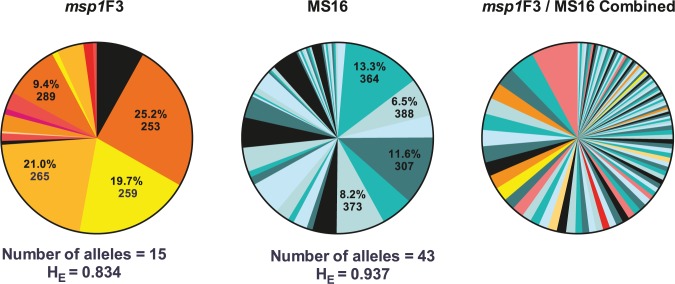
Diversity of P. vivax genotypic markers msp1F3 and MS16.Allelic frequencies of P. vivax msp1F3, MS16 and the combined msp1F3 / MS16 haplotypes. For msp1F3 and MS16, the frequency of the four most common alleles and respective sizes (in basepairs) are shown. The number of unique alleles identified and the estimated expected heterozygosity (HE) are given below the figure.